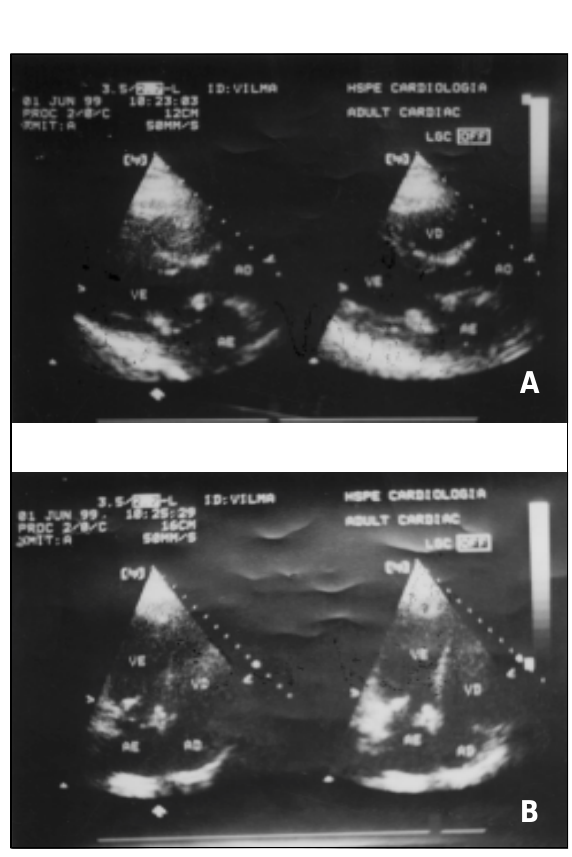
Fig. 2 - Ecocardiograma transtorácico revelando: A) prótese biológi- ca em posição aórtica sem vegetações. B) prótese biológica em posição mitral sem vegetações (vide